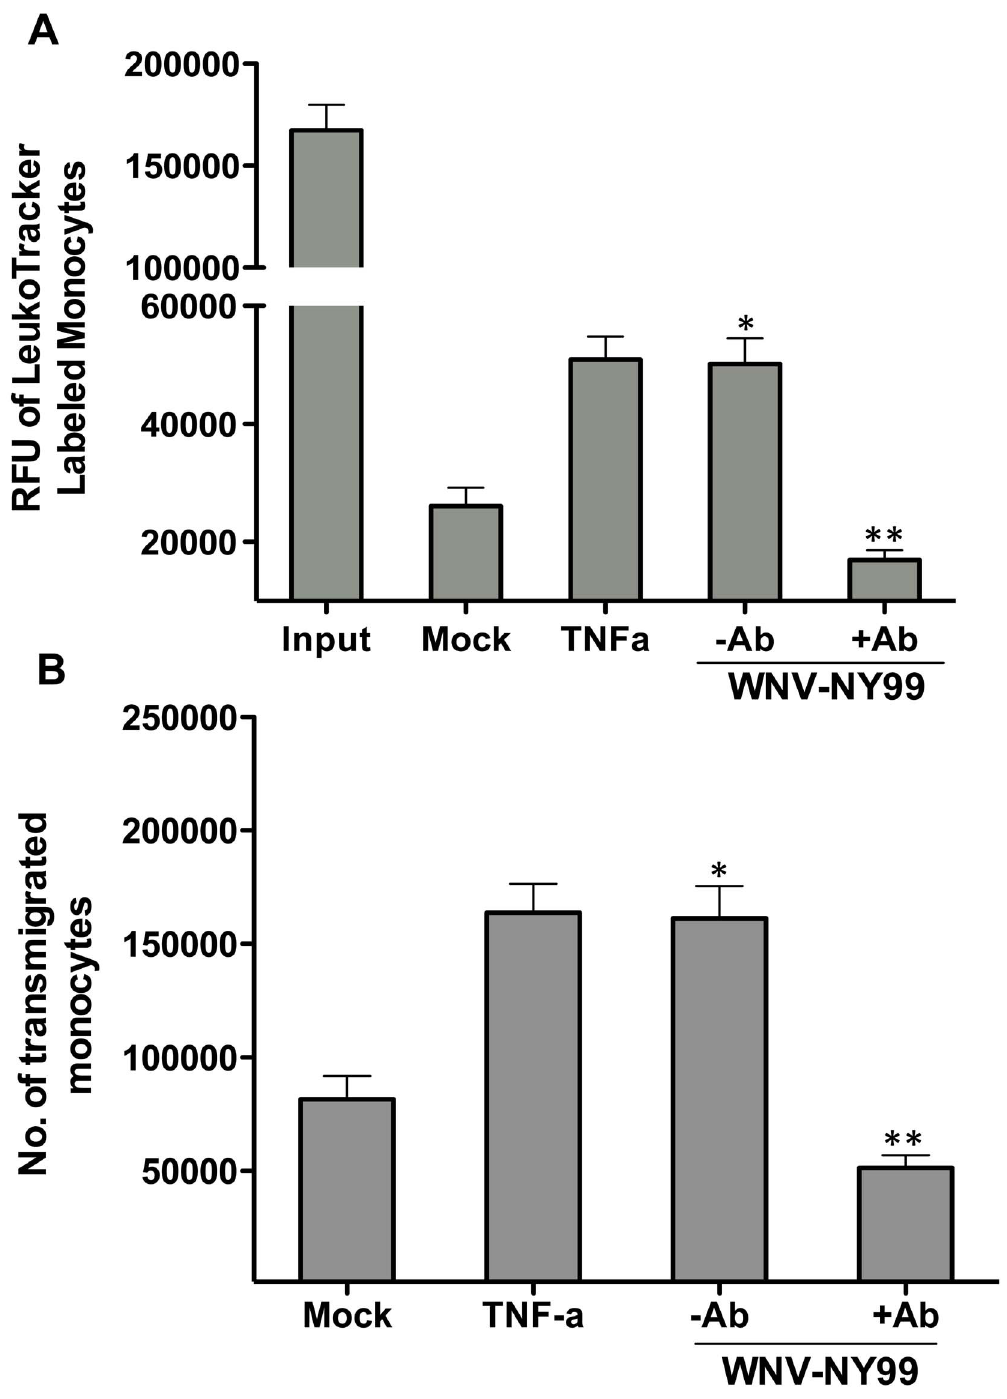
Figure 6. Blocking CAMs limits the transmigration of monocytes across the invitro BBB model. Human monocytes stained with leukotracker dye were added to the upper compartment of the in vitro BBB model infected with NY99 strain of WNV in the presence or absence of neutralizing antibodies against ICAM-1, VCAM-1 and E-slectin. Treatment with TNF- a (0.125 ng/mL) was used as a positive control. After four hrs of incubation, the media of the lower compartment was collected and the flourescence was measured. ( A ) Flourescence absorbance (RFU) of the transmigrated monocytes in the lower compartment. ( B ) Absolute number of transmigrated monocytes extrapolated based on the standard curve generated using RFU of known number of leukotracker stained monocytes. The data is representative of two independent experiments. *p , 0.05 compared to mock and **p , 0.05 compared to WNV-infected.